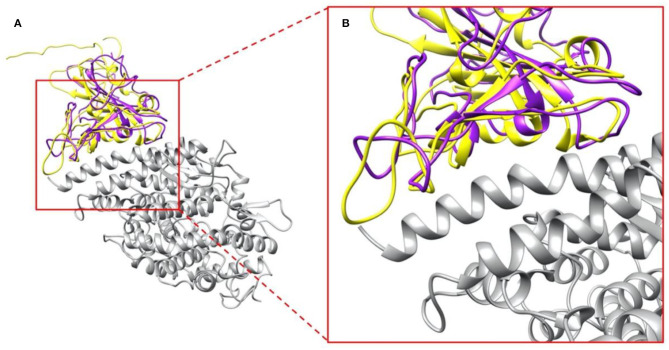
Complex structures of S protein RBDs and ACE2 protein. (A) SARS-CoV S protein RBD (purple) and SARS-CoV-2 S protein RBD (yellow) bind with human ACE2 binding domain (gray); (B) A closeup view of (A), the interface area of SARS-CoV S protein RBD (purple) and SARS-CoV-2 S protein RBD (yellow) with human ACE2 binding domain (gray).